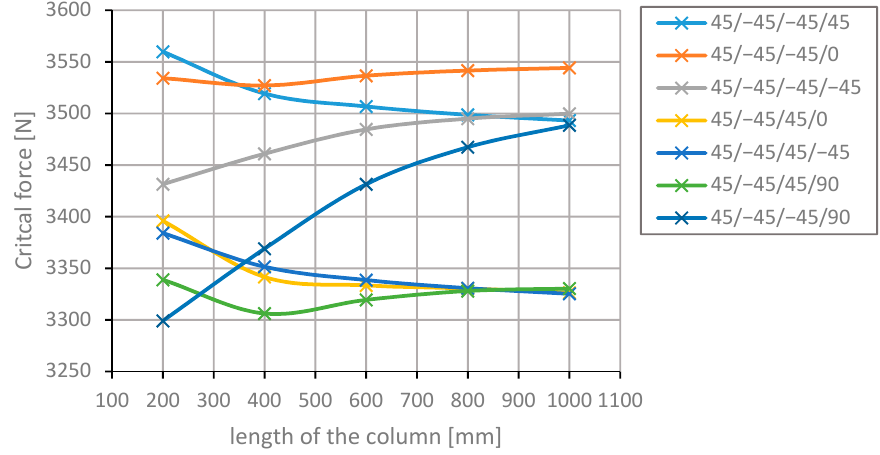
Figure 5. Changes in the value of the critical force for different arrangements of the laminate layers at different lengths of the column.